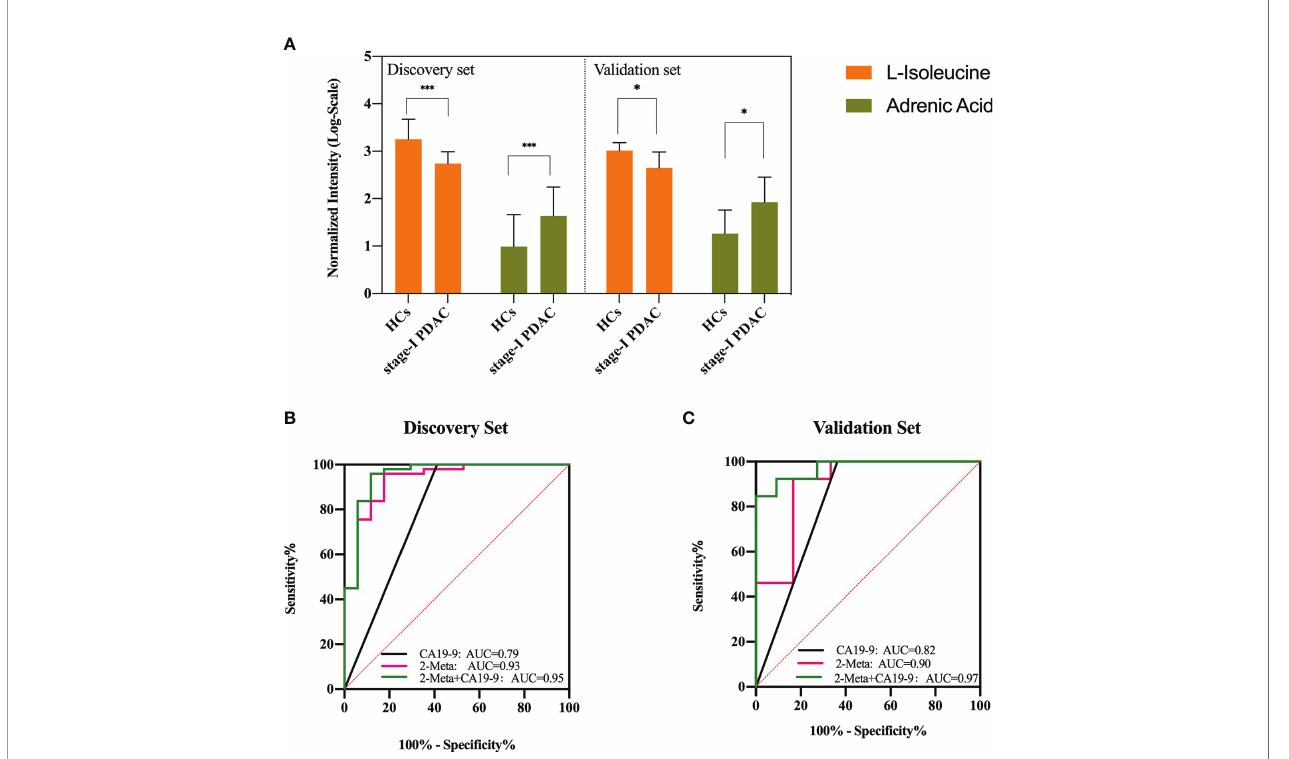
FIGURE 3 | (A) Serum concentrations of de fi ned potential biomarkers in the discovery and validation sets, respectively. * represents p<0.05, *** represents p<0.001. (B, C) ROC curves of the two-metabolite model, CA19-9, and the combination of two-metabolite model and CA19-9 in the discovery set and validation set. AUC, area under the curve. The red line indicates the metabolite model, black line indicates CA19-9 (cutoff = 37 U/ml), and green line indicates the metabolite model plus